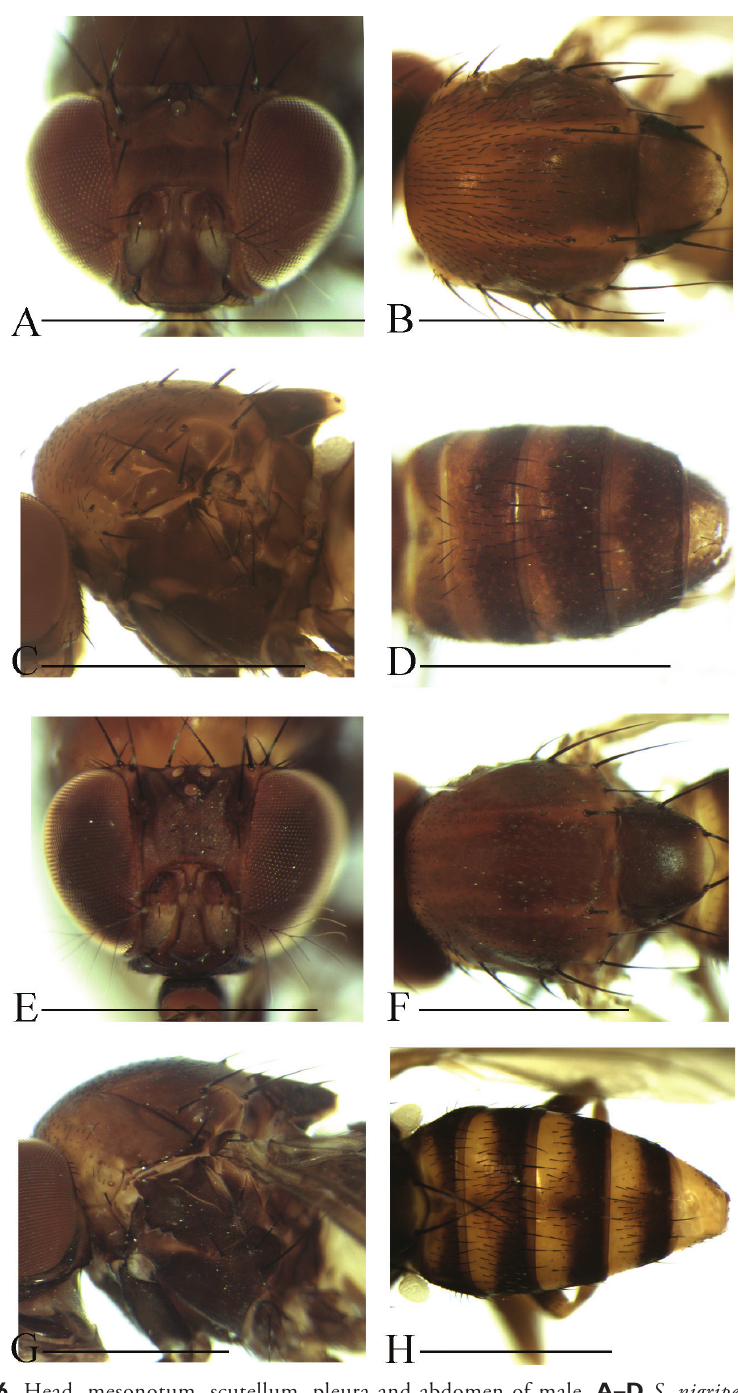
Figure 6. Head, mesonotum, scutellum, pleura and abdomen of male. A–D S. nigripecta sp. n. E–H S . obscurata sp. n. Scale bars 1